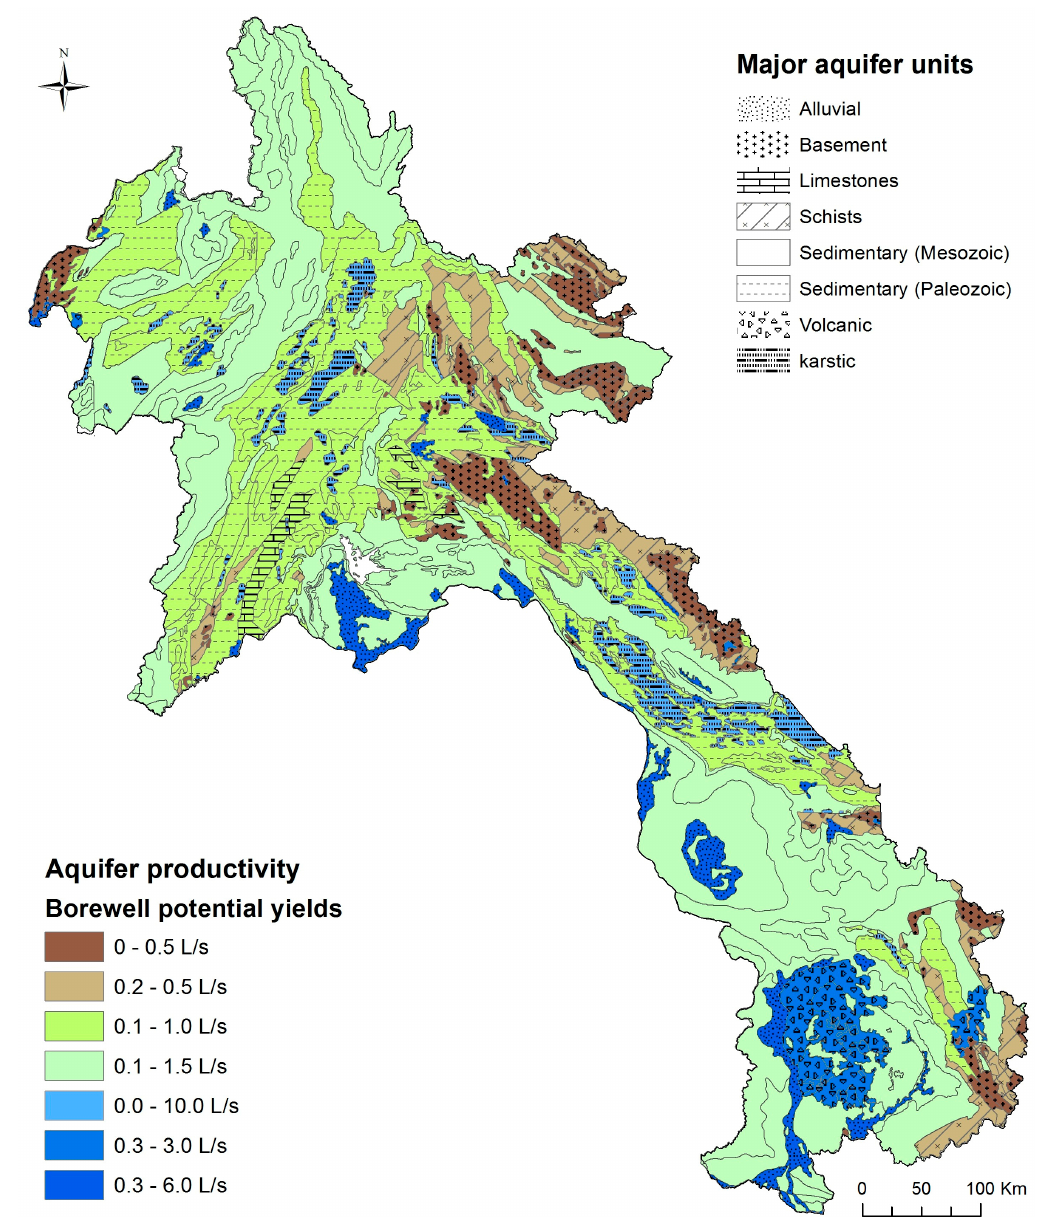
Figure 6. Map of shallow aquifer productivity in Laos.